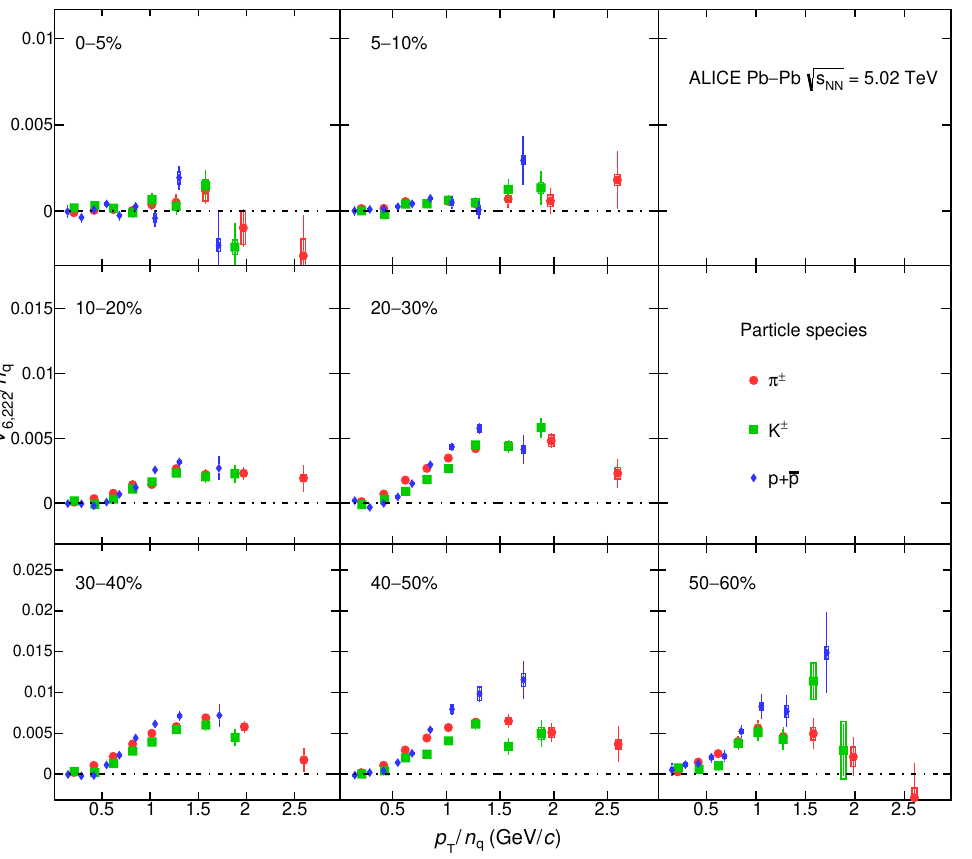
Figure 13 . The p T =n q -dependence of v 6 ; 222 =n q for di(cid:11)erent particle species grouped into di(cid:11)erent p centrality intervals of Pb-Pb collisions at s NN = 5 : 02 TeV. Statistical and systematic uncertainties are shown as bars and boxes,